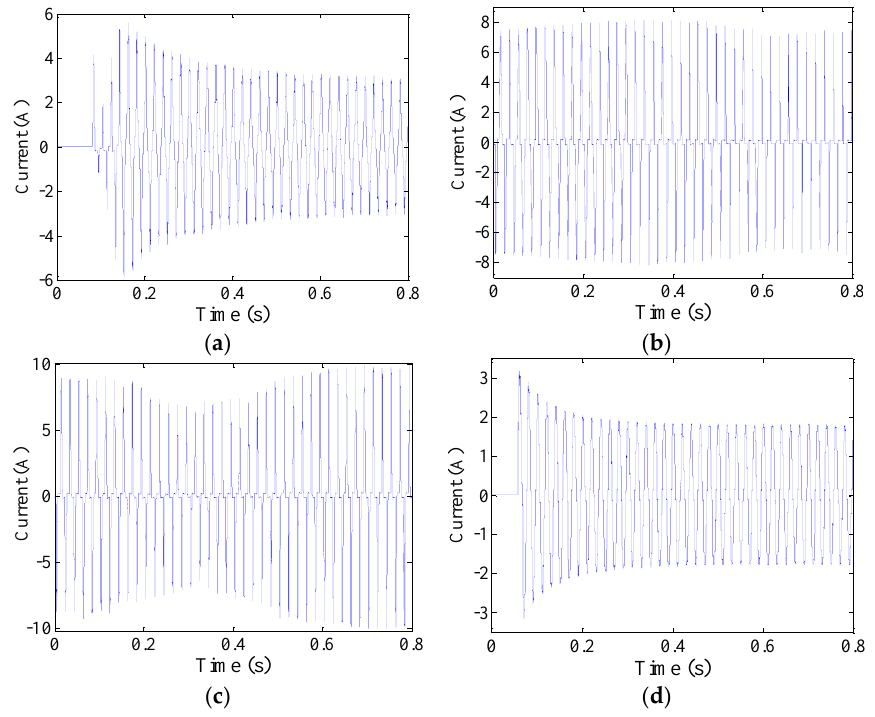
Figure 12. Currents of transient processes: ( a ) starting an electrical drill; ( b ) dimming lamps; ( c ) regulating the speed of a vacuum cleaner; ( d ) plugging in a halogen lamp.